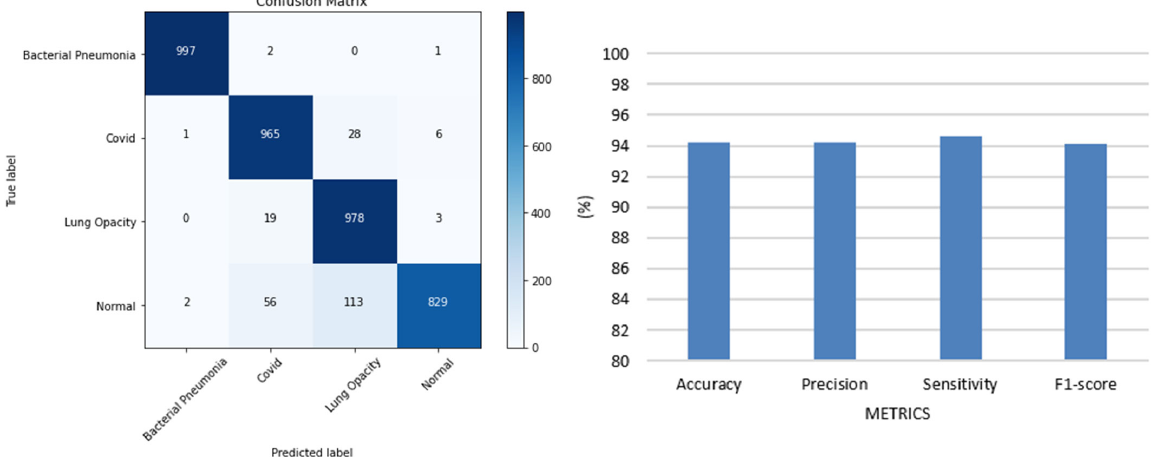
Figure 11. Confusion matrix and bar chart diagram of accuracy, precision, sensitivity, and F1-score of FirecovNet for the dataset that was not used in its training phase.